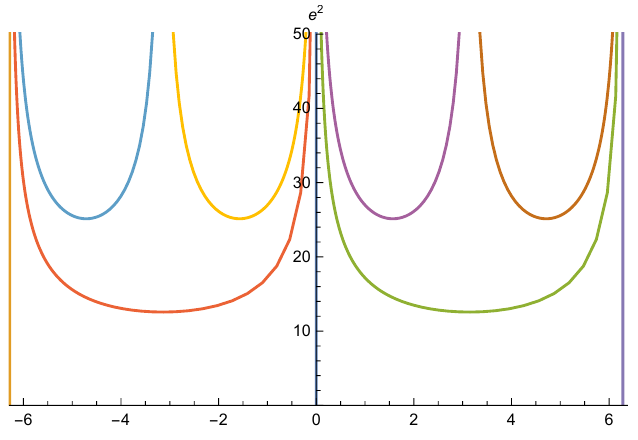
Figure 2 . The same as figure 1, but now plotted in the ( θ, e 2 )